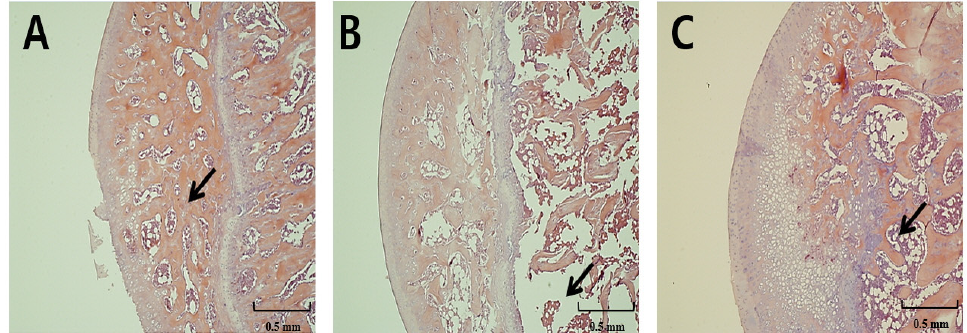
Figure 1. Representative light micrographs of right femur sections of rats ( × 5). ( A ) SHAM-operated, ( B ) ovariectomized, and ( C ) ovariectomized fed with Superjami rice bran extract. Arrows indicate spaces within the trabeculae that are empty or filled with bone cells.